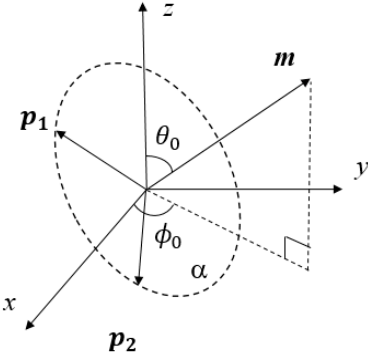
Figure 2. Normal vector diagram.